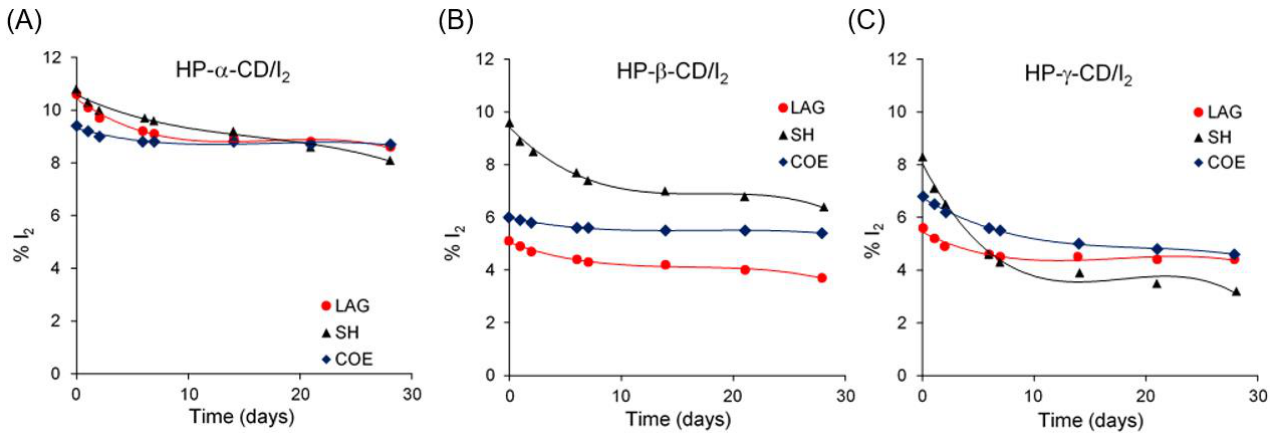
Figure 6. Variation of the iodine content with time in the accelerated stability testing of ( A ) HP- α - CD/I 2 , ( B ) HP- β -CD/I 2 and ( C ) HP- γ -CD/I 2 complexes prepared by LAG, COE or SH method.